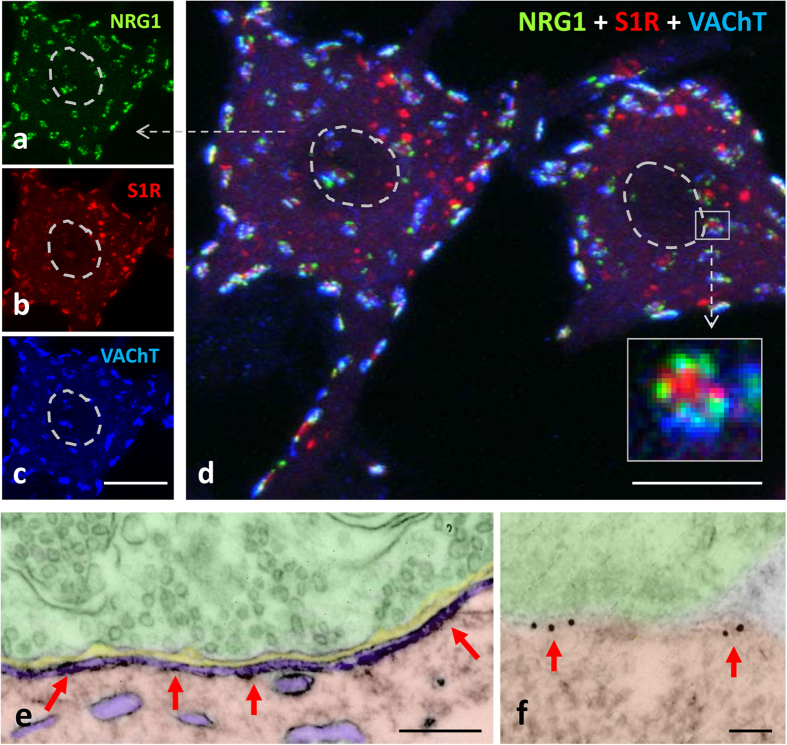
NRG1 protein is associated with the C-bouton proteins VAChT and S1R, and localized in SSC at postsynaptic region.(a–d) Squashed MNs triple immunolabelled for NRG1 (green), S1R (red) and VAChT (blue). The three molecules colocalise at C-boutons, but S1R is also present as non-synaptically-associated particles. The nuclei are delimited by a dashed line. Individual RGB channels of the indicated MN (arrow) are shown in (a-c). When individual C-boutons are observed at high magnification (square delimited in (d)), sites containing S1R are segregated from NRG1-positive patches, and delimited by presynaptic VAChT. (e and f) NRG1 accumulates in the SSC (arrows) as shown in spinal cord MNs after ultrastructural immulolabelling by a pre-embedding (e) or post-embedding immunogold (f) procedure. Scale bars: in (c) = 10 μm; (d) = 20 μm; in (e) = 250 nm; in (f) = 50 nm.